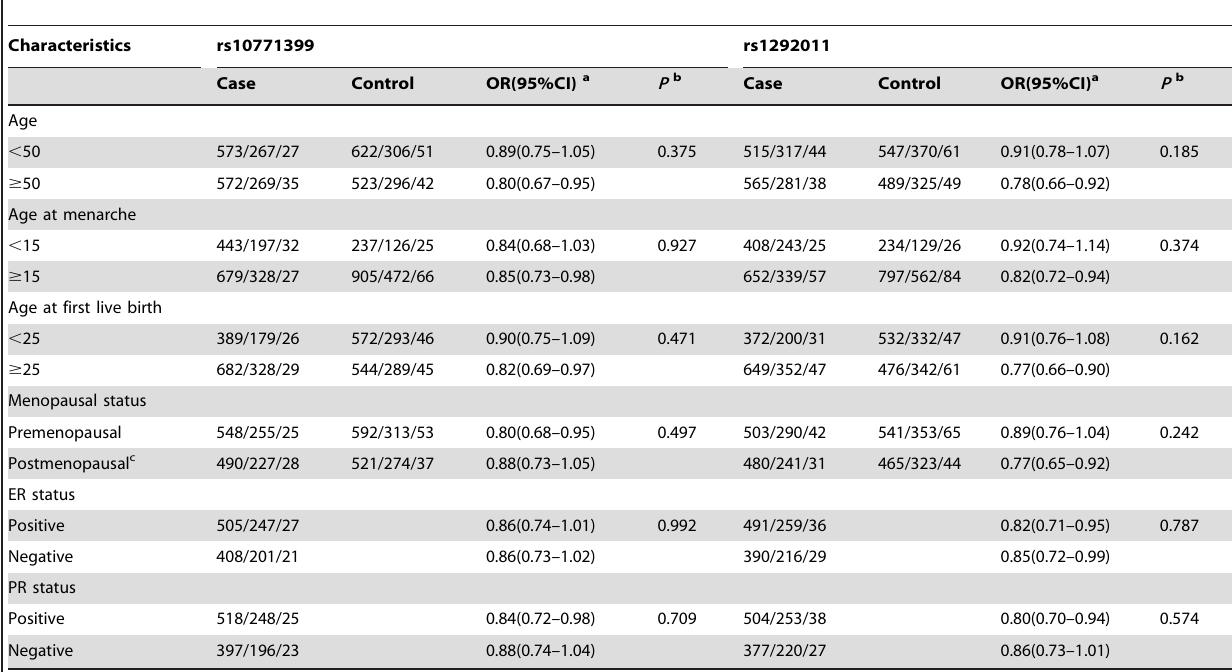
Table 3. Stratified analysis on the associations of rs10771399 at 12p11 and rs1292011 at 12q24 with breast cancer risk.